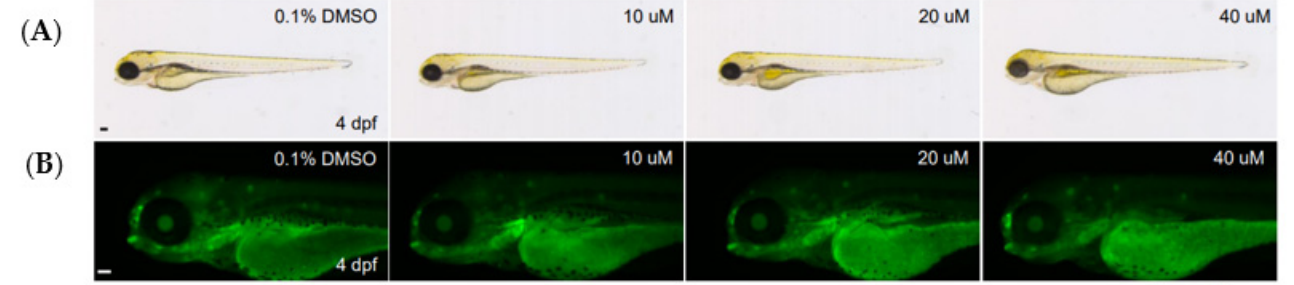
Figure 7. ( A ) Effects of compound 9 on later stage zebrafish larvae (4 dpf) at their respective concentrations of 10, 20, and 40 µM. ( B ) Detection of apoptosis or cell death via acridine orange, fluorescent vital dye staining. Non-specific signals in yolk and eye lens are autofluorescence shown in both the control and compound 9-treated animals.